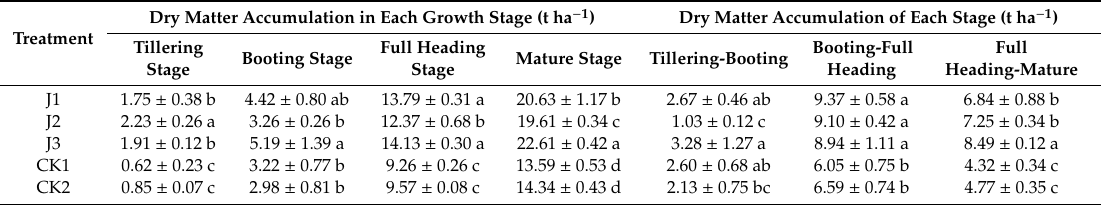
Table 2. The dry matter accumulation of rice under the applied fertilization methods.